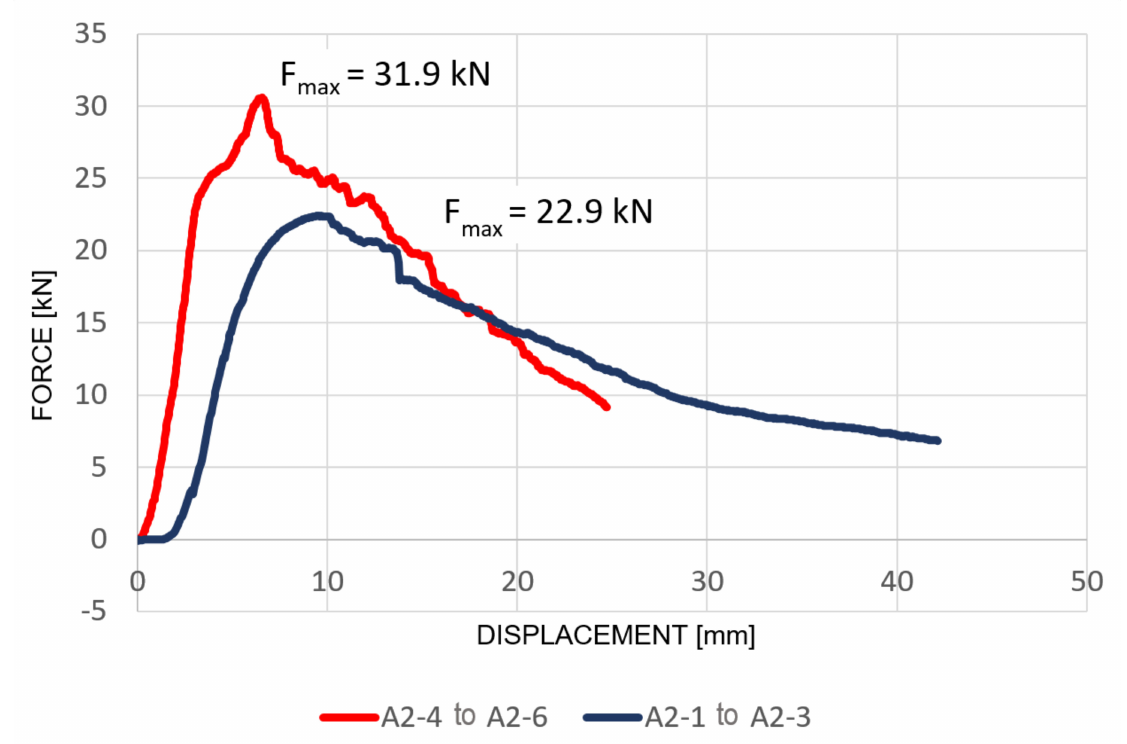
Figure 22. Graph of average values of monitored quantities for both sets of slabs made from